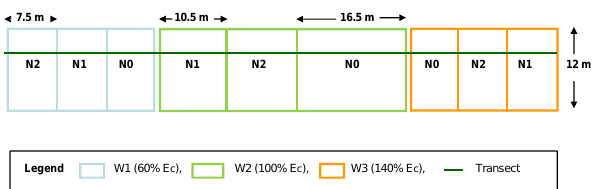
Fig. 1. An illustration of the experimental layout. Only the nine subplots of the melon crop experiment through which the wheat transect ran are shown. The wheat transect is shown by the dark green line. The fertilizer levels are shown on the figure: N0, N1, N2 represent 0, 150 and 300kg N ha − 1 respectively. The three different irrigation levels are indicated by the colour of the subplot lines: light blue is W1, the light green W2, and the orange W3 corresponding to 60%, 100%, and 140% of the estimated crop evapotranspiration ( E c ) respectively.